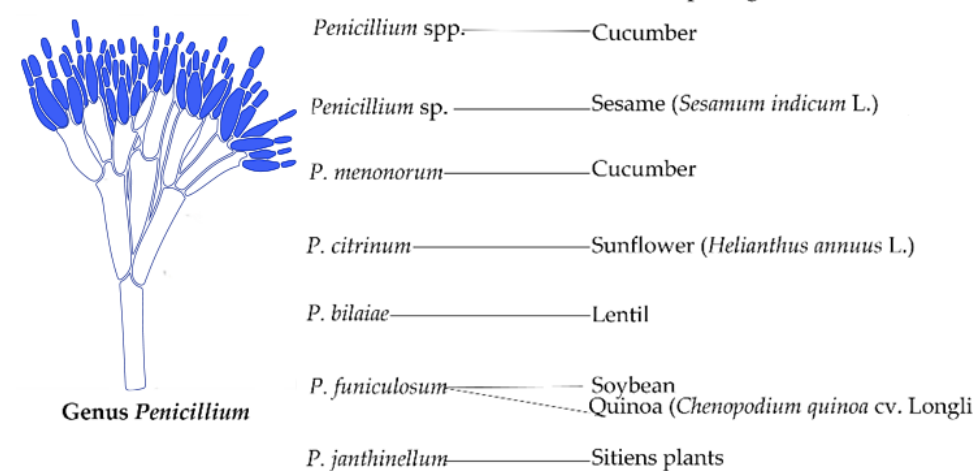
Figure 2. Species of the genus Penicillium used in the promotion of plant growth.